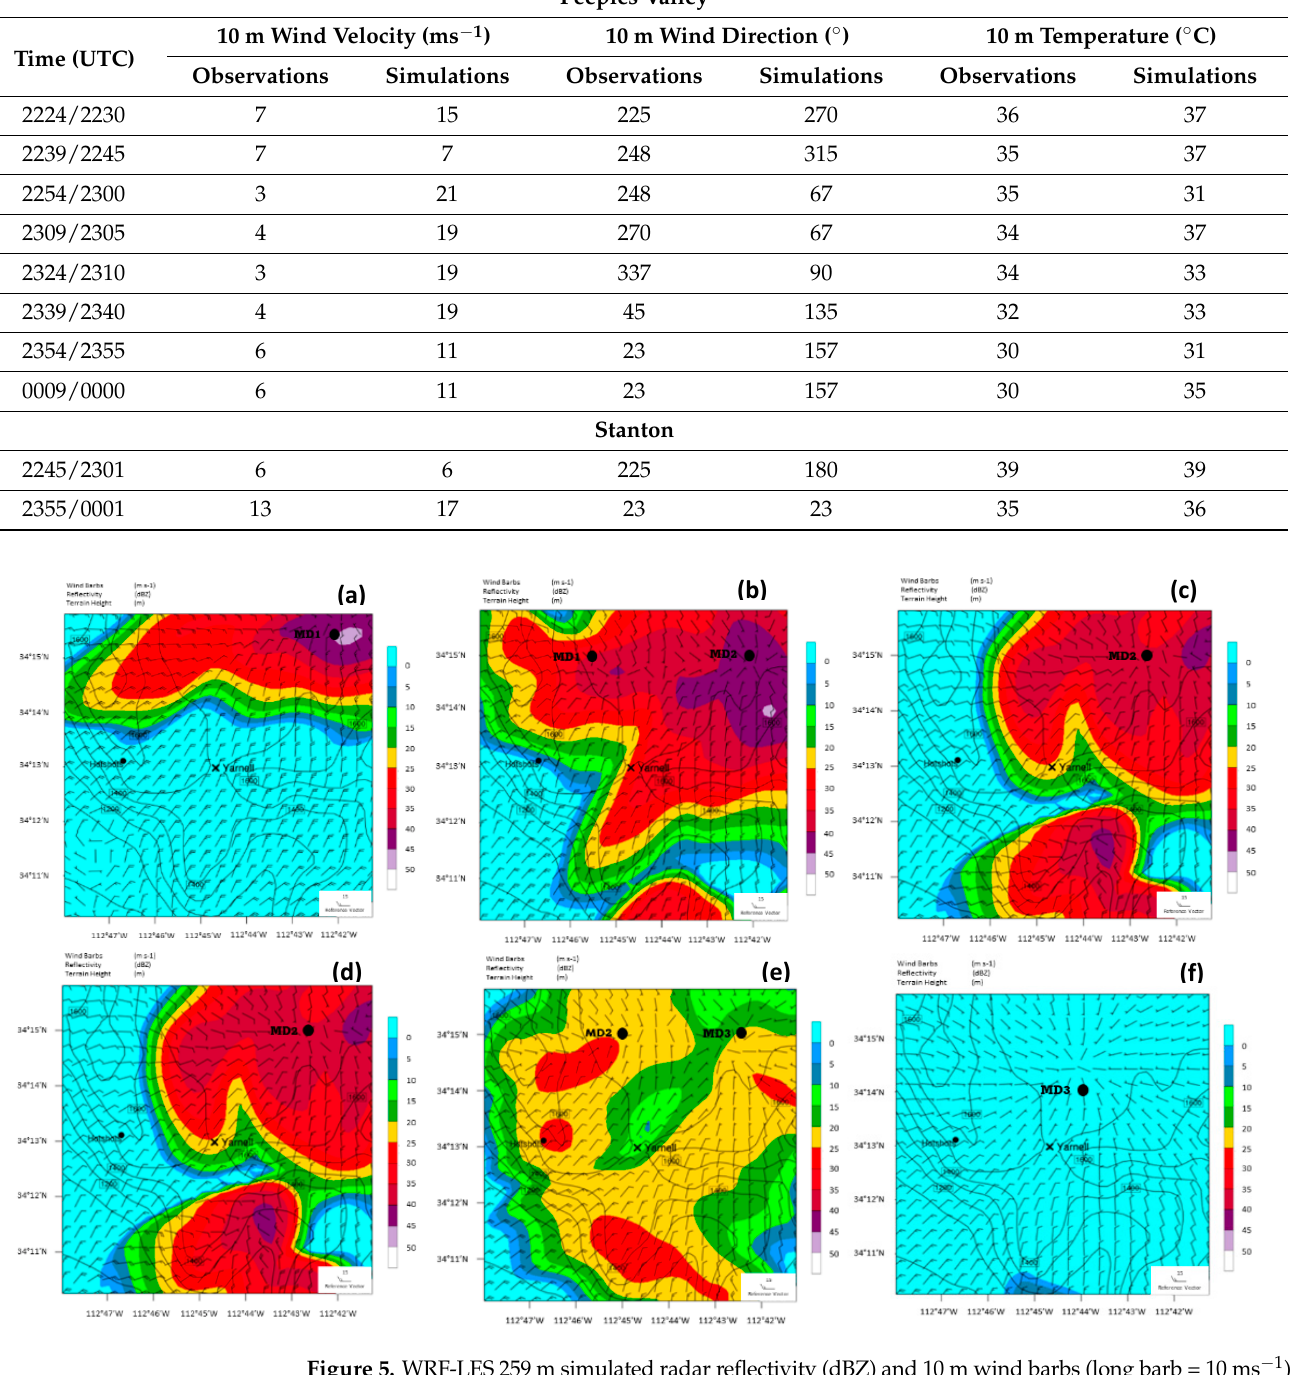
Figure 5. WRF-LES 259 m simulated radar reflectivity (dBZ) and 10 m wind barbs (long barb = 10 ms − 1 ) over the zoomed-in region valid at ( a ) 2315, ( b ) 2325, ( c ) 2335, ( d ) 2345, ( e ) 2350, and ( f ) 2355 UTC 30 June 2013. Solid lines are terrain elevation (m). MD denotes the microburst outflow/surface diffluence zone.